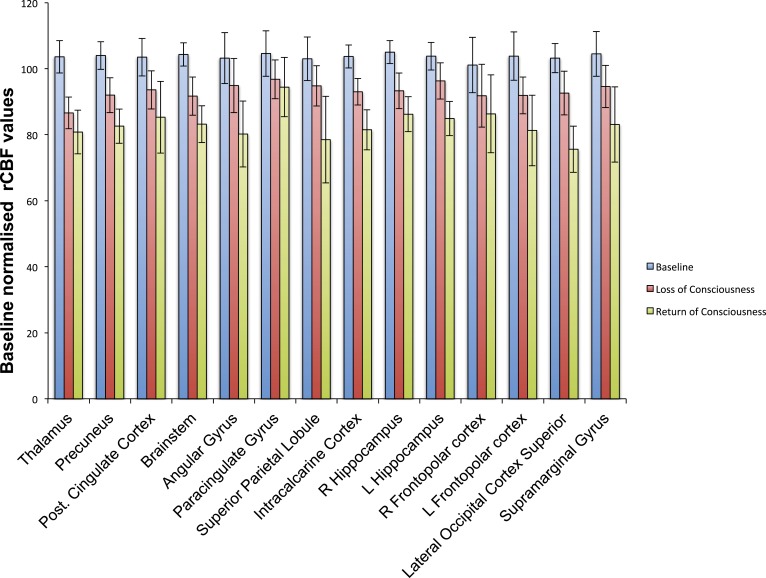
Cortical decrease in rCBF persists during the recovery of consciousness.Statistically significant rCBF clusters from Figure 1D were extracted and intersected with the Harvard–Oxford cortical and subcortical map arbitrarily thresholded at 30. Subjects were aligned to LOC/ROC and then median baseline normalized rCBF values obtained for each time point. For LOC (n = 17) and ROC (n = 16), an average of baseline-normalized rCBF values corresponding to the 2 min immediately preceding and post LOC/ROC behavioral time points are represented. The decreased rCBF values from baseline observed during the LOC were sustained during the ROC. L, left; LOC, loss of consciousness; Post, posterior; rCBF, regional cerebral blood flow; R, right; ROC, return of consciousness.